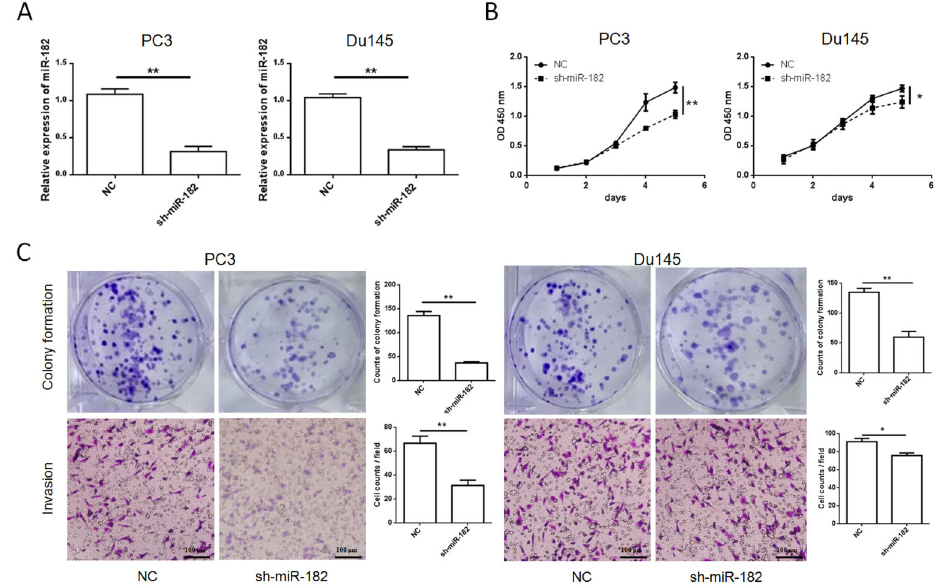
Figure 2. Knockdown of miR-182 inhibited prostate cancer cell proliferation and invasion in vitro . A , shRNA was designed to knockdown endogenous miR-182, and qRT-PCR indicated its expression was decreased by transduction of sh-miR-182 lentivirus in PC3 and Du145. B , CCK-8 assay was used to evaluate cell proliferation. C , Knockdown of miR-182 signi fi cantly inhibited colony formation and invasion of PC3 cells (scale bar 100 m m). Data are reported as means ± SD. *P o 0.05; **P o 0.01 (paired t -test and one-way ANOVA). NC: negative